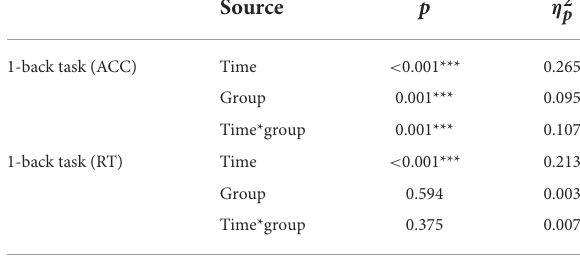
TABLE 4 1-back task